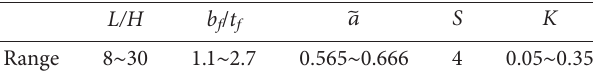
Table 6: The valid applicable ranges of parameters in the